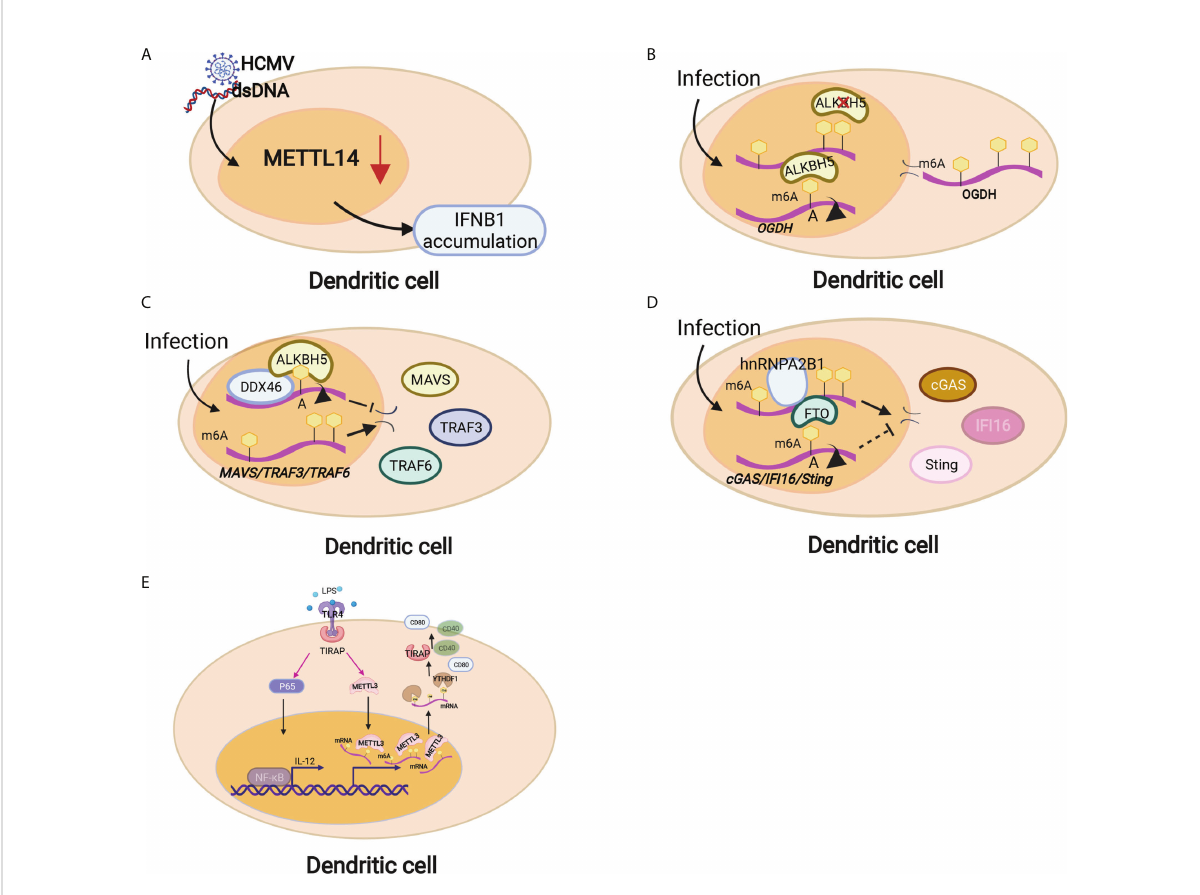
FIGURE 3 Dendritic cells are regulated by m6A modi fi cations through different mechanisms. (A) METTL14 depletion inhibited viral reproduction and promoted dsDNA- or HCMV-induced IFNB1 mRNA accumulation. (B) Downregulation of ALBKH5 in DCs increased m6A modi fi cations on OGDH mRNA and reduced its mRNA stability and protein expression, thereby inhibiting viral replication. (C) The RNA helicase DDX46 demethylates the antiviral proteins MAVS, TRAF3 and TRAF6 by recruiting ALBKH5. (D) hnRNPA2B1 recognizes viral DNA and facilitates m6A modi fi cation nucleocytoplasmic traf fi cking of CGAS, IFI16, and STING mRNAs by preventing FTO-mediated demethylation. (E) Mettl3-speci fi c depletion in DCs results in delayed maturation in response to lipopolysaccharide (LPS) and impaired phenotypic and functional maturation of DCs. Mechanistically, the expression of the costimulatory molecules CD40 and CD80, the TLR4 signaling adaptor Tirap and the cytokine IL-12 decreased with a low capacity to stimulate T-cell